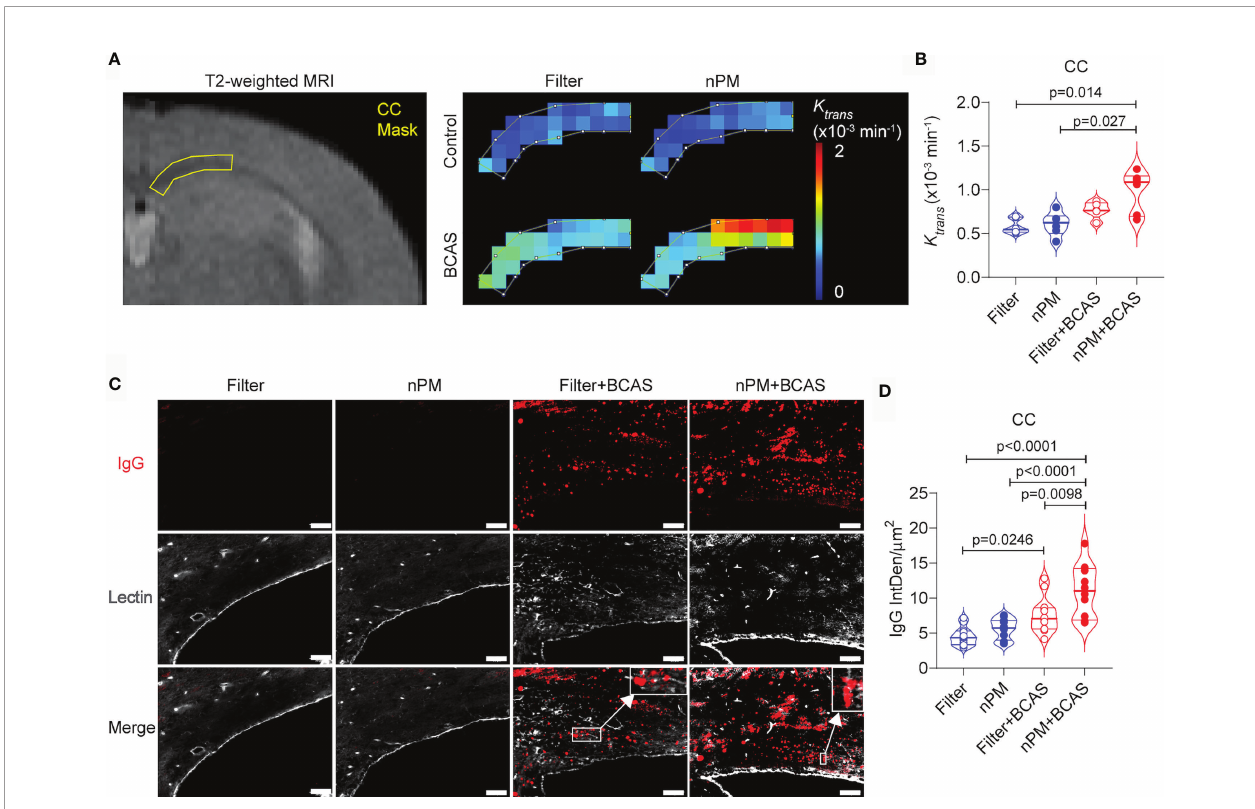
FIGURE 3 | nPM exposure exacerbates white matter blood brain barrier leakage after bilateral carotid artery stenosis. (A, B) Corpus callosum blood brain barrier (BBB) permeability was measured in vivo by using dynamic contrast enhanced MRI. Distribution of gadolinium-based contrast agent was followed during the scan and regional BBB transfer constant (K trans , x10 -3 min -1 ) was mapped (A) and quanti fi ed (B) in the corpus callosum area. In panel (B) n=6 in fi lter, nPM and nPM+BCAS groups and n=5 in fi lter+BCAS group. (C) BBB leakage was visualized postmortem by staining for extravascular IgG deposits. IgG positive deposits (red) outside lectin (white) positive blood vessels were quanti fi ed and presented as integrated density (D) . In panel (D) n=12 in all groups. Data is presented as violin plot with median and quartiles. 1-way ANOVA and Bonferroni Post Hoc tests were used for statistical testing. Scale bar = 50 µm in panel (C) . CC, corpus callosum; nPM, nanoparticulate matter; IgG, Immunoglobulin G; IntDen, integrated